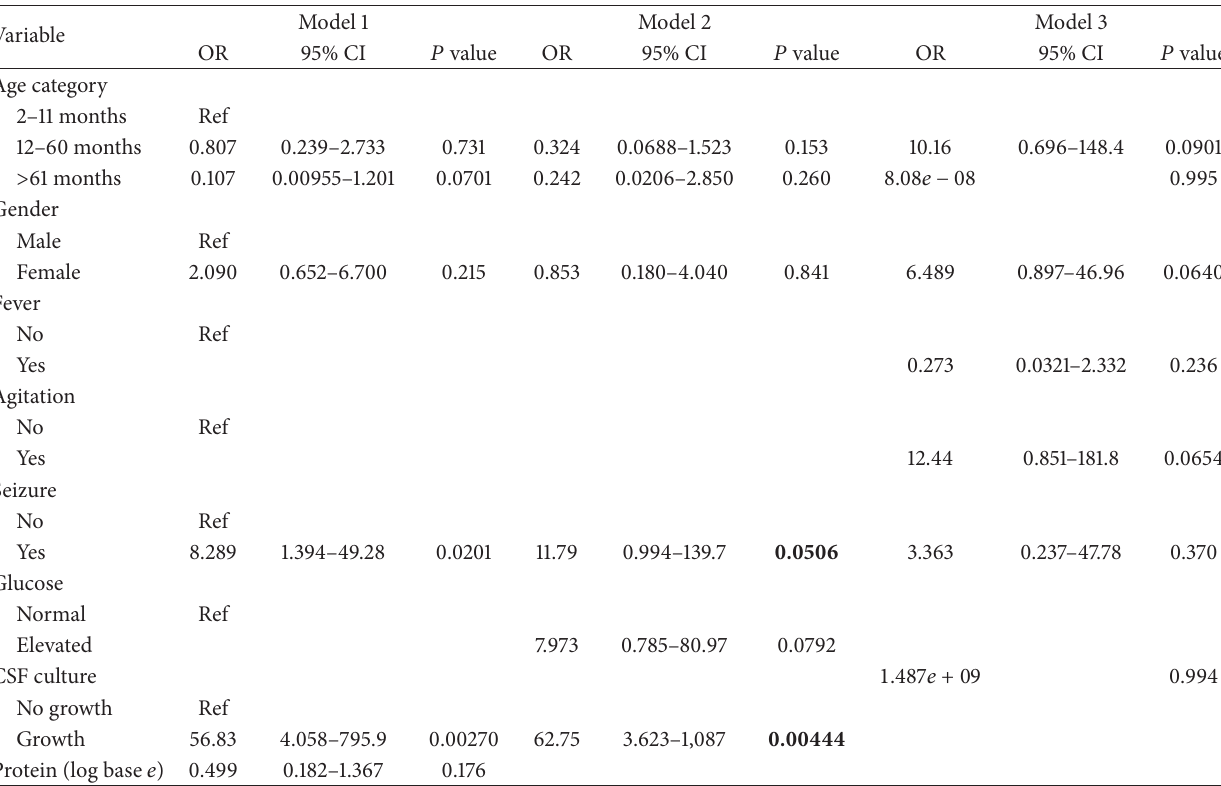
Table 5: Multivariable ordinary logistic